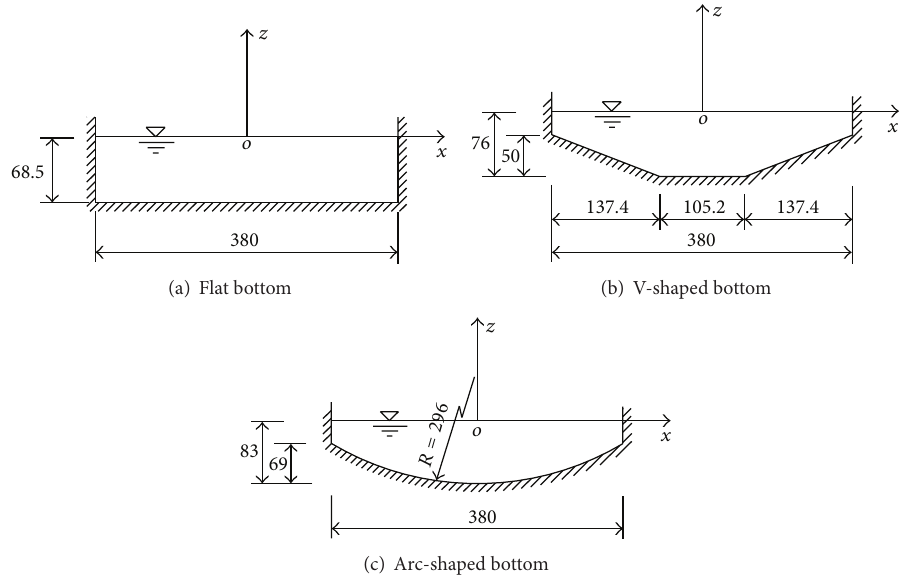
Figure 5: Various shape tuned liquid dampers (length unit: mm).